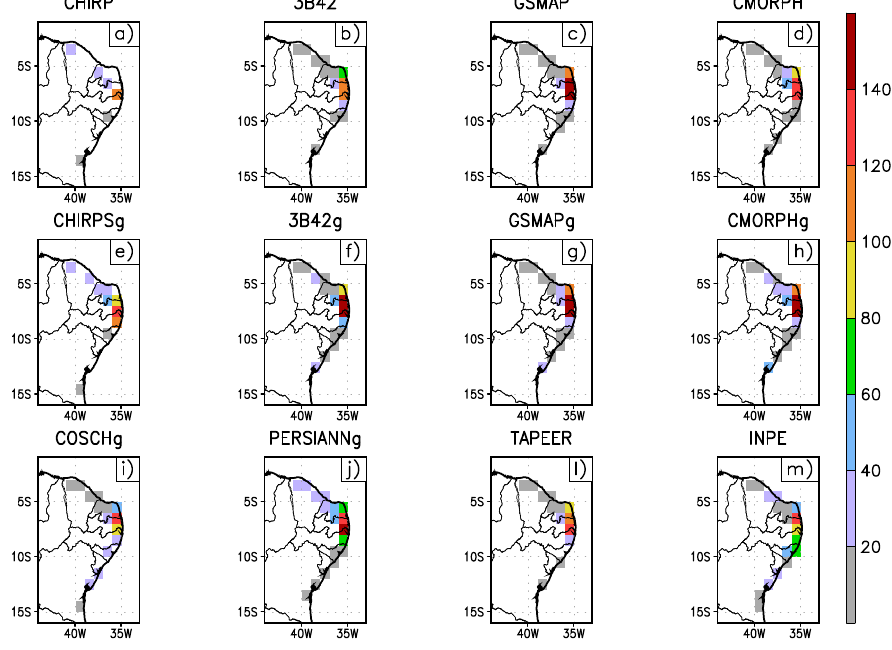
Figure 17. Case of extreme precipitation occurred over northeast coast of Brazil (R4) from 14 April 2016 to 18 April 2016 estimated by different products ( a – m